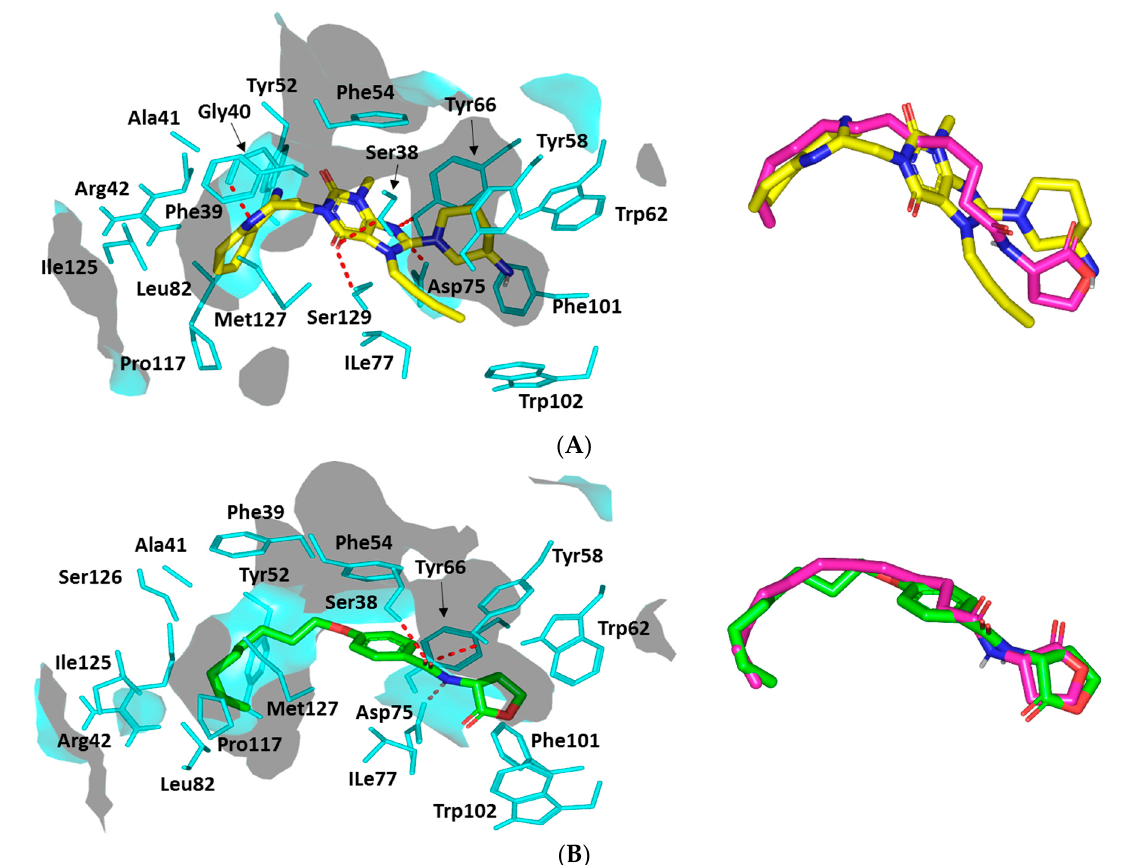
Figure 11. Ligand–protein binding interactions at Pseudomonas aeruginosa QscR quorum-sensing transcription protein binding site. Predicted binding modes of the docked ligands ( A ) LIN and ( B ) Q9 as cyan and green sticks, respectively. Only residues located within 5 Å radius of bound ligands are displayed (cyan lines) and labeled with a sequence number. Non-polar hydrogens are removed for clarity and hydrogen bonds are depicted as red dashed lines. The right panels are an overlay of LIN or Q9 with the co-crystalline ligand, C12-HSL, as magenta sticks.